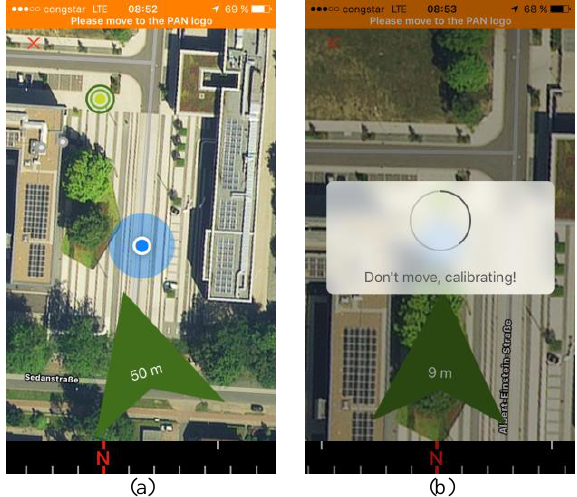
Figure 2. Simple navigation to a POI (a) and subsequent compass calibration (b).